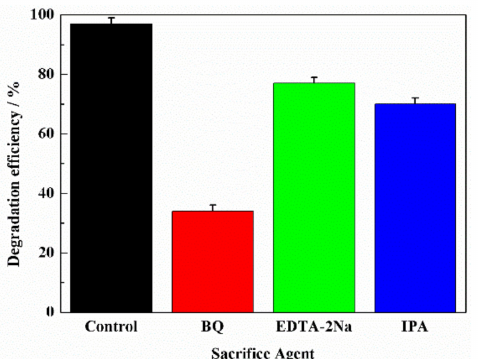
Figure 8. Trapping experiments of active species during the photocatalytic degradation of RhB with